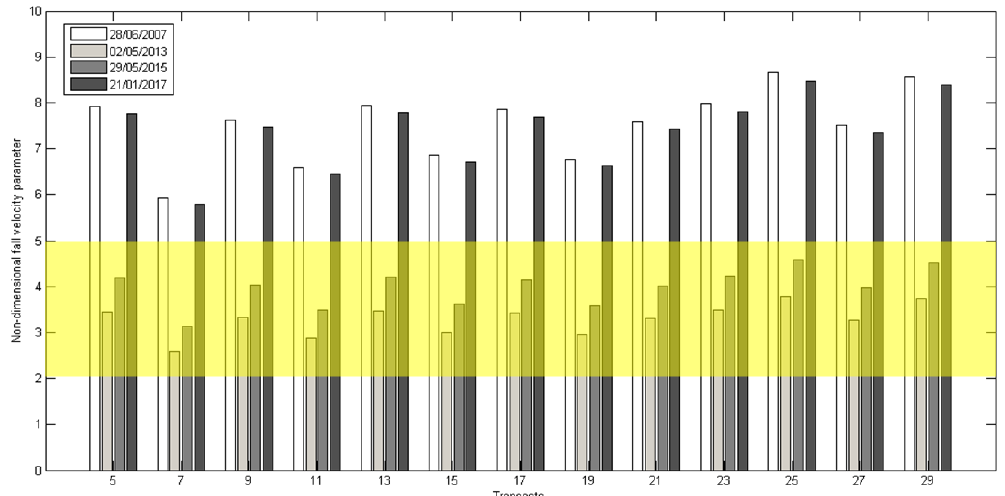
Figure 8. Histogram of the (cid:127) values of each transect. The yellow strip is the range mostly associated with rip currents (Castelle et al.,